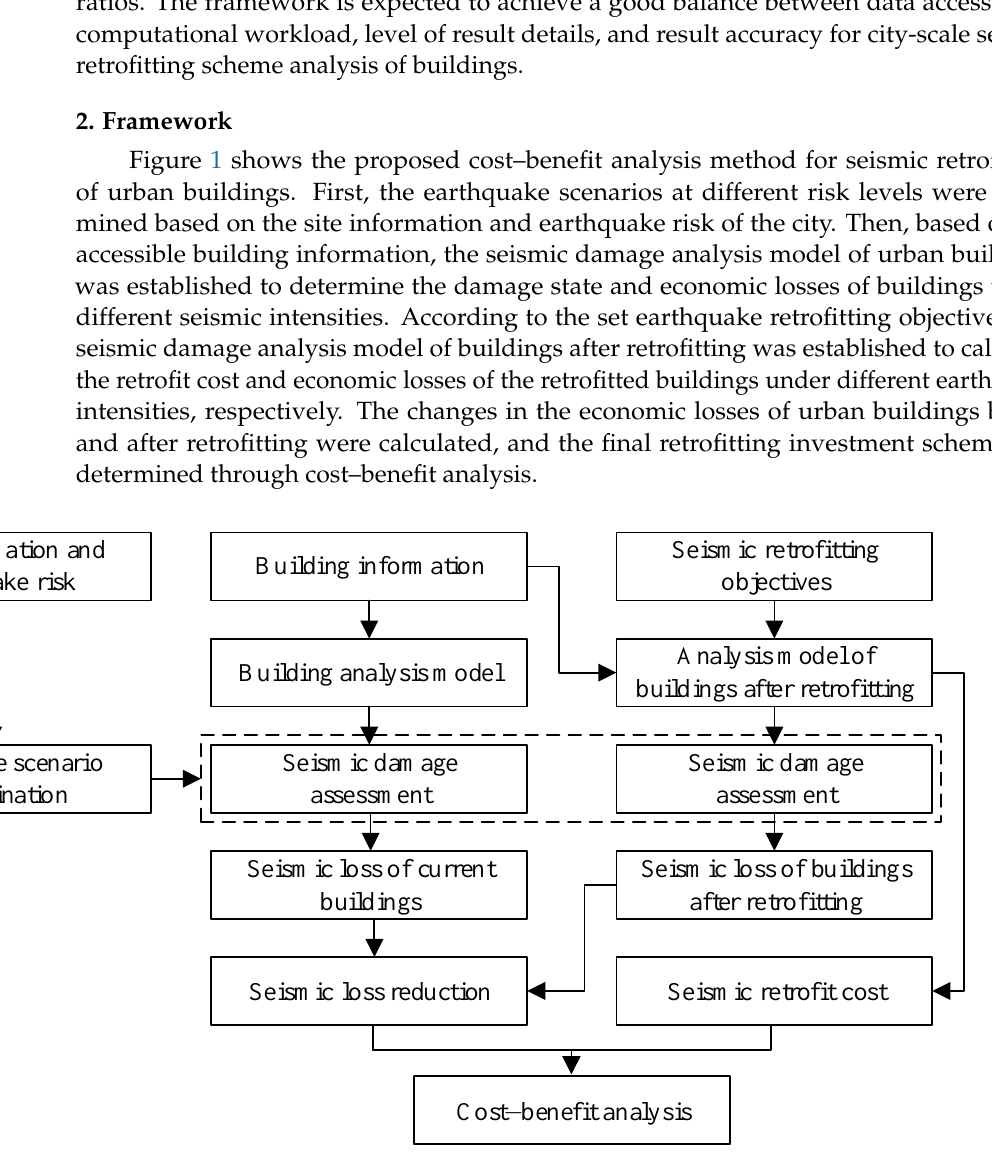
Figure 1. Proposed cost–benefit analysis framework for city-scale seismic retrofitting scheme of buildings.